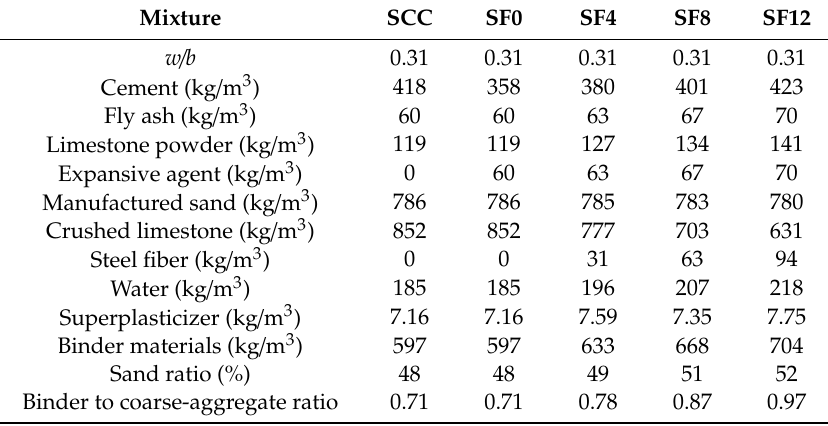
Table 4. Mix proportion of SCC and self-compacting